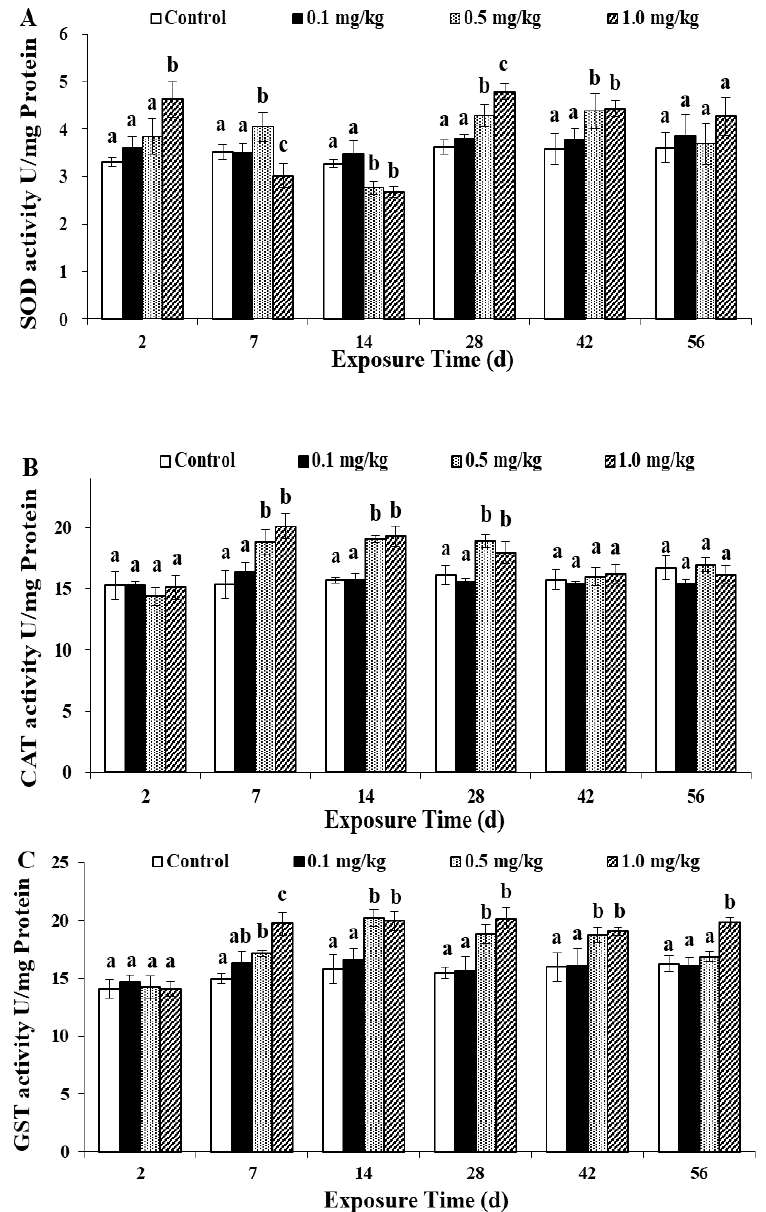
Figure 4. Effects of sulfoxaflor on the superoxide dismutase (SOD) ( A ), catalase (CAT) ( B ) and glutathione S-transferase enzyme (GST) ( C ) activities in earthworms. Bars are the means ± SD of five replicates. Different letters indicate significant differences ( p < 0.05) between treatments.